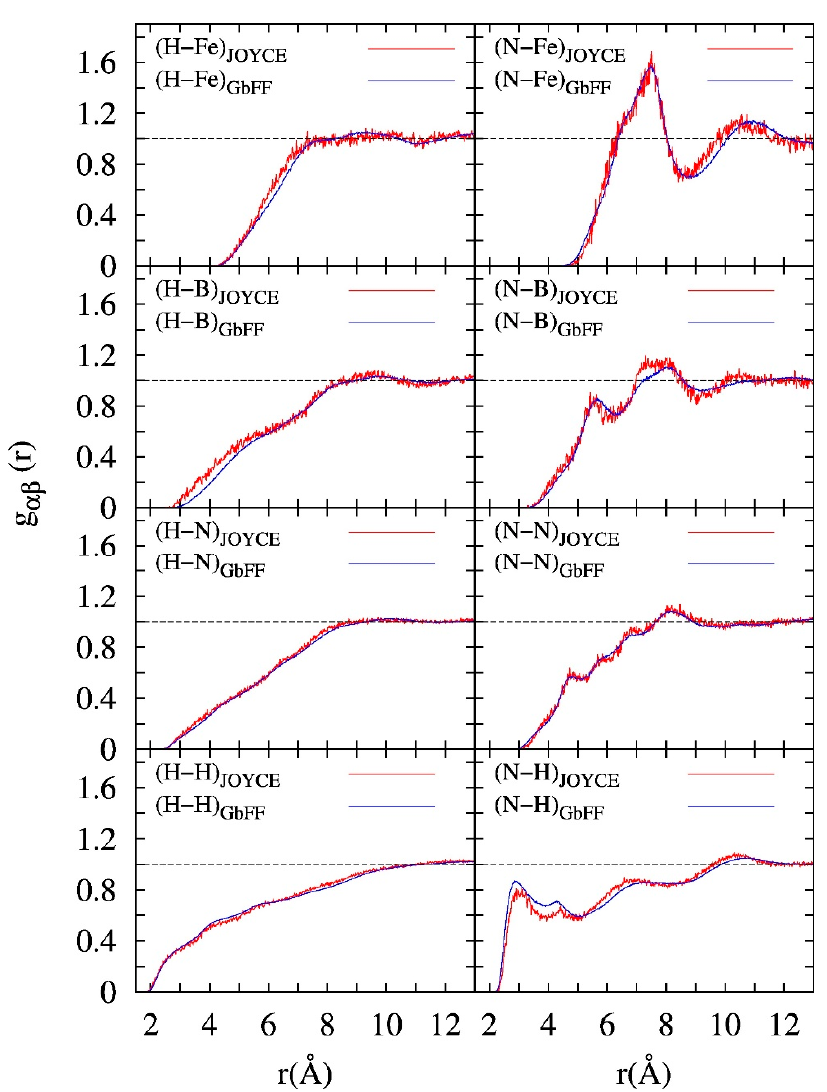
Figure 5. Atomic pair correlation functions g αβ , computed along the J OYCE (red) and GbFF (blue) MD simulation runs, between the solute ( β ) atoms (Fe, B, N and H from -CH 3 group) of the complex as indicated in the ( α - β ) legend, and either the N (left part) or H (right part graphs) atoms of the acetonitrile solvent ( α ).